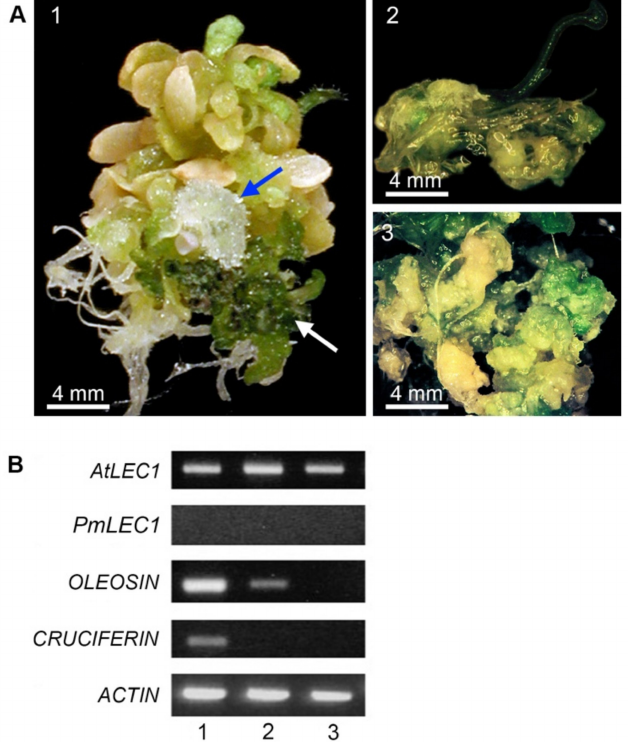
Figure 5. Morphology and gene expression profiles of Arabidopsis lec1-1 AtLEC1 T2 seedlings show similarities to lec1-1 PmLEC1 T2. ( A ) Morphological variants 1, 2 and 3 of the AtLEC1 -containing transgenic line. Blue arrow indicates somatic embryo-like masses. White arrow indicates dark green cotyledon-like structures. ( B ) RT-PCR analysis of gene expression. Each reaction comprised 0.1 µ g DNase I-treated total RNA isolated from the indicated plant material. The analyzed genes are provided to the left of the corresponding panels. Lanes 1, 2 and 3 represent transcripts from the respective morphological variants 1, 2 and 3, shown in panel